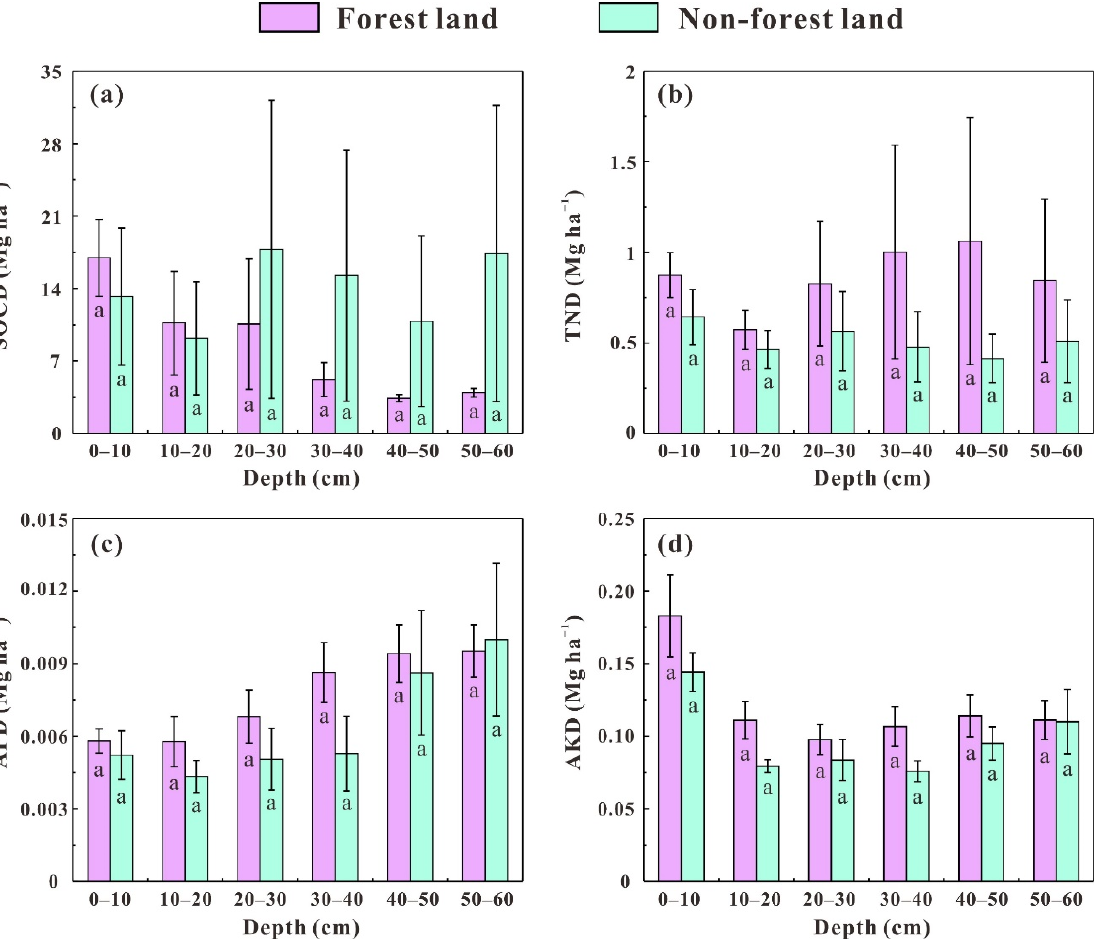
Figure 5. The average SOCD ( a ), TND ( b ), APD ( c ), and AKD ( d ) values in forest land and non-forest land. The same letters indicate that there is no significant difference between the two data groups. The error bars represent the standard errors of different groups.